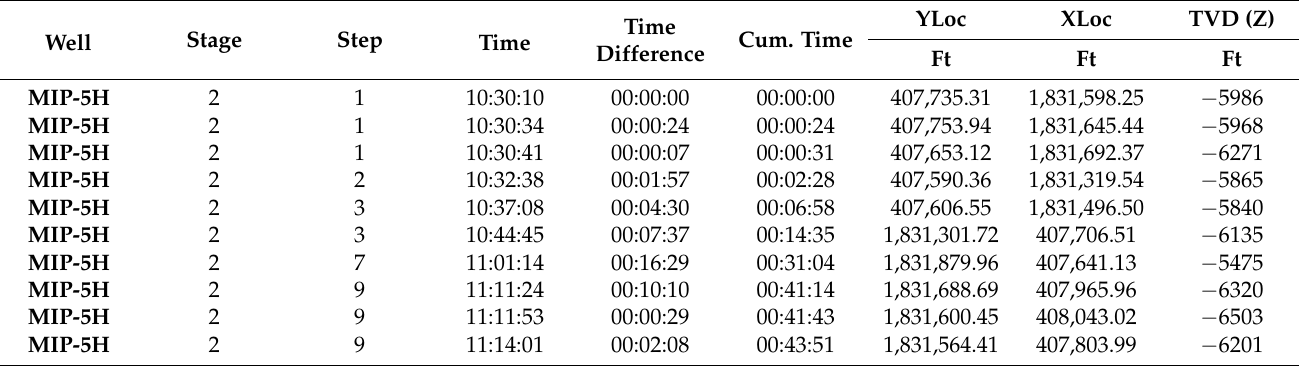
Table 2. The generated table for MS.